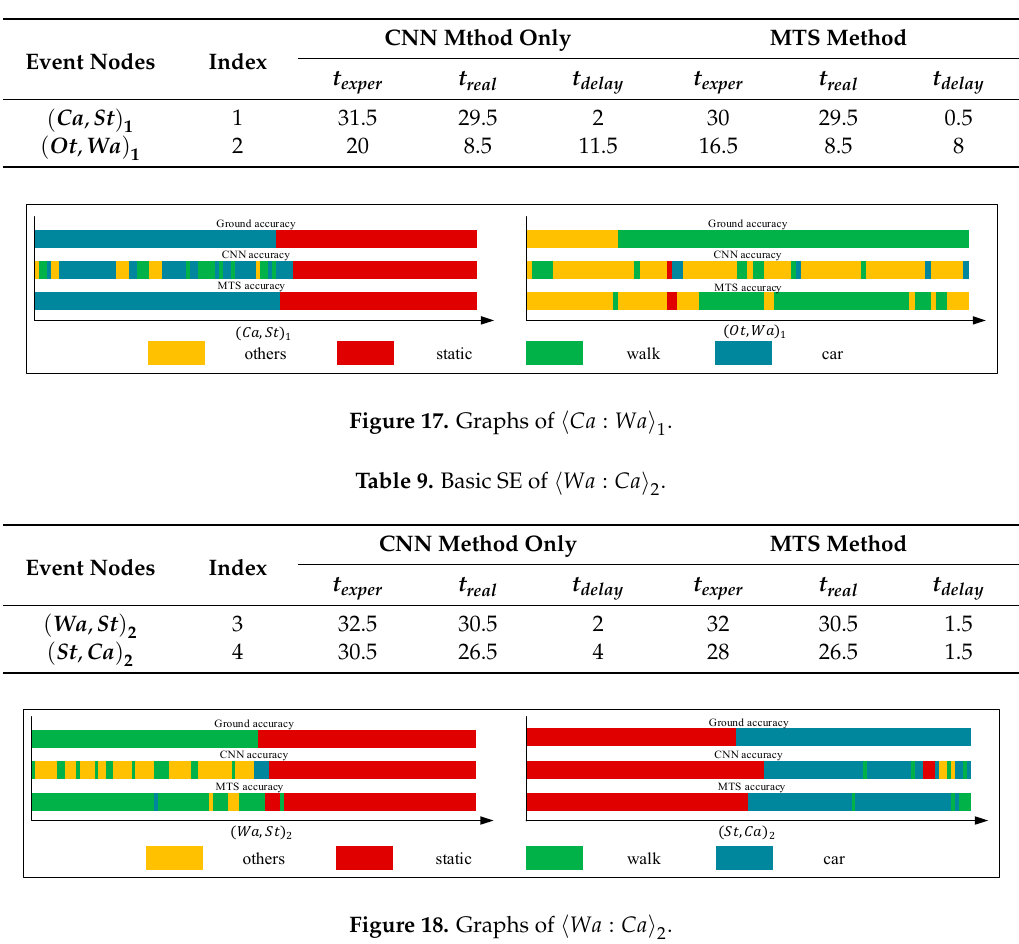
. Table 8. Basic SE of < (cid:1829)(cid:1853): (cid:1849)(cid:1853) > 1 (cid:2869) .